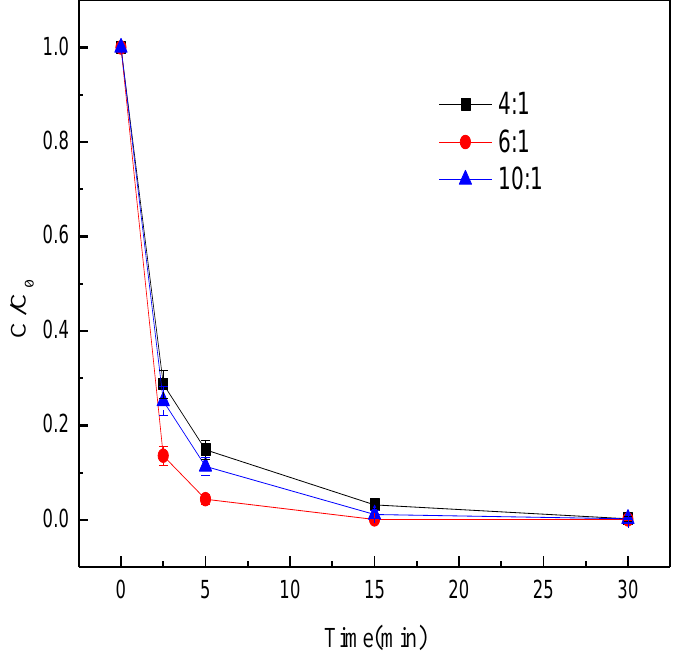
Figure 3. Effects of mass ratio of Fe/C on the decolorization efficiency of methyl orange.